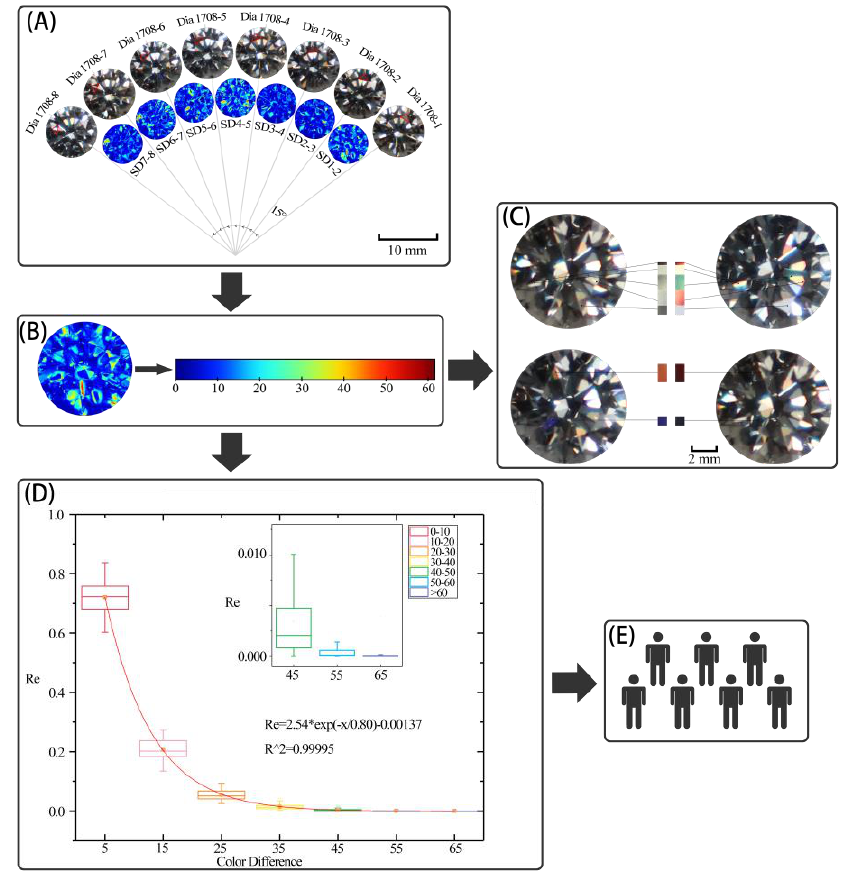
Figure 2. Schematic of the experimental process. ( A ) Each sample was photographed after being rotated counterclockwise by 0° to 105° at 15° intervals and the color difference between pixels of adjacent rotation angle images was calculated (the size of each image was 500 × 500 pixels, and take Dia 1708 as an example). ( B ) The color difference was divided into seven color difference intervals for subsequent analysis by entropy method. ( C ) In order to divide the color difference interval, contrasting blocks on the diamond image were selected (seven of which are shown in this figure). The standard deviation (representing the resolution of chromaticity) of the pixels’ color difference were calculated to determine the color difference threshold. ( D ) The box plot showed the percentage of the number of data in each color difference interval to the number of all data for each sample, which decreased with increases in color difference intervals. The entropy method was used to analyze these data to quantitatively evaluate the diamond scintillation. ( E ) The diamond scintillation was visually evaluated by seven experienced graders with professional knowledge to verify the result by entropy method.